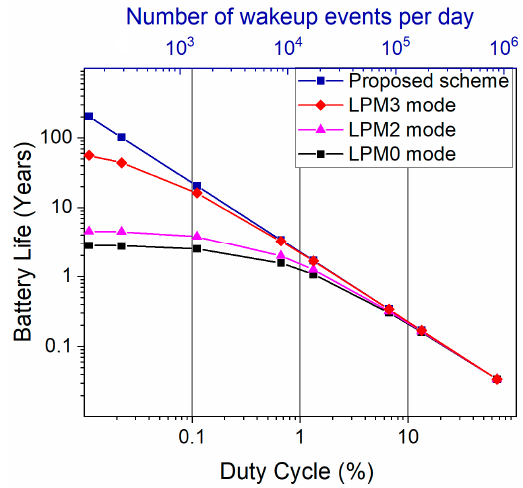
Figure 12. Comparison of expected battery life for cyclic and adaptive schemes with respect to corresponding duty cycle, and the number of wakeup events.